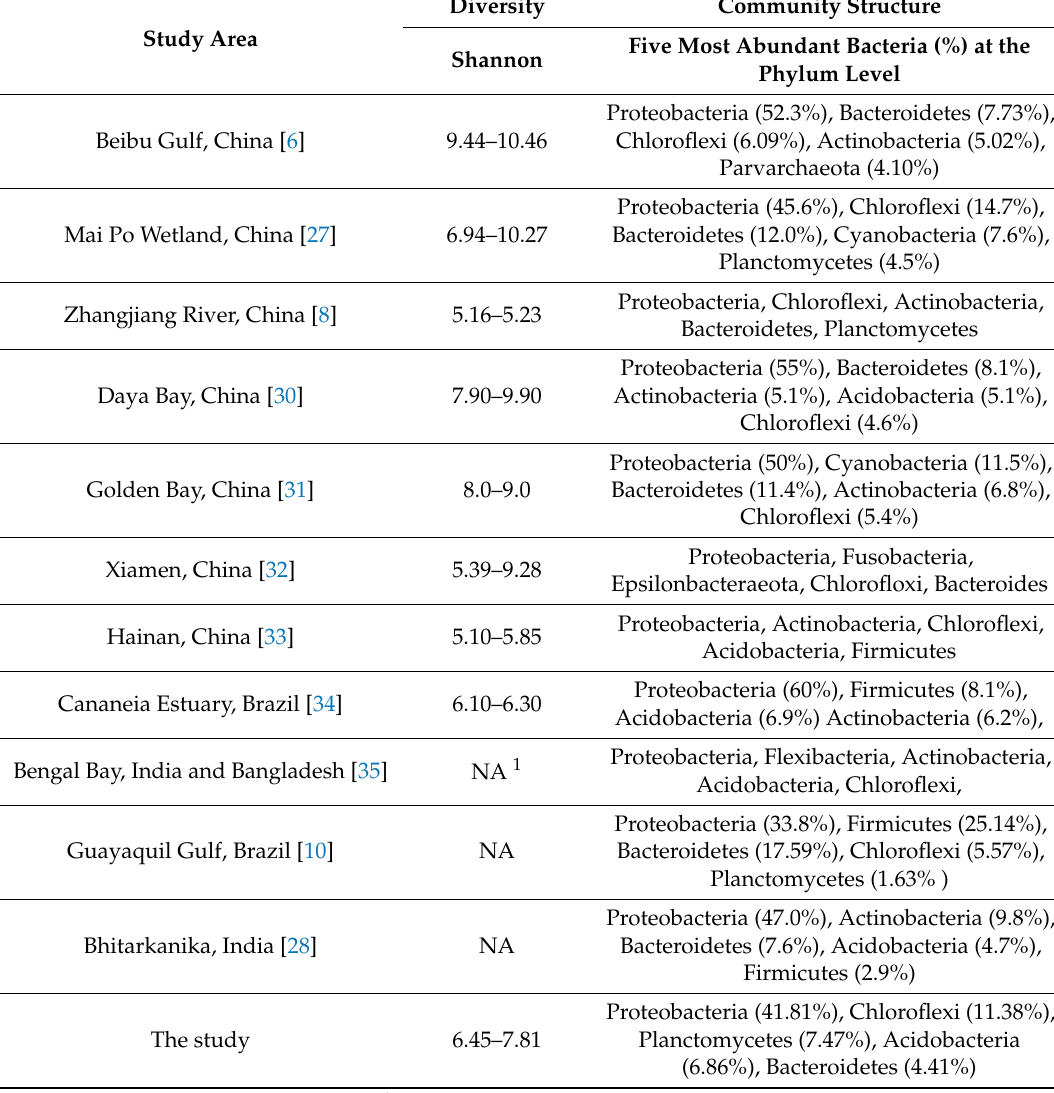
Table 4. Comparison of bacterial diversity and community structure in mangrove soils between this study and other reference sites around the